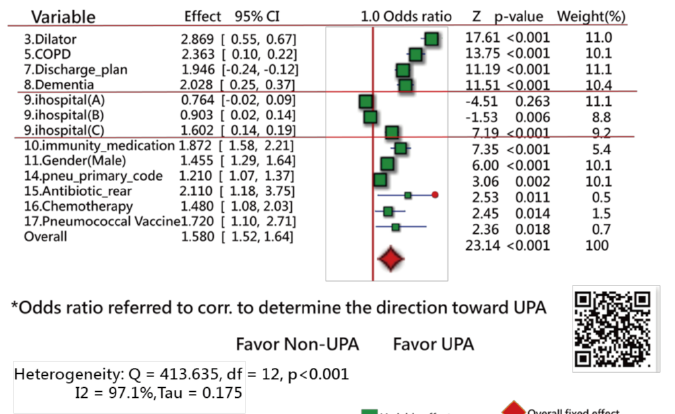
Figure 3. Feature variables using a forest plot to present the interpretation based on the odds ratio method